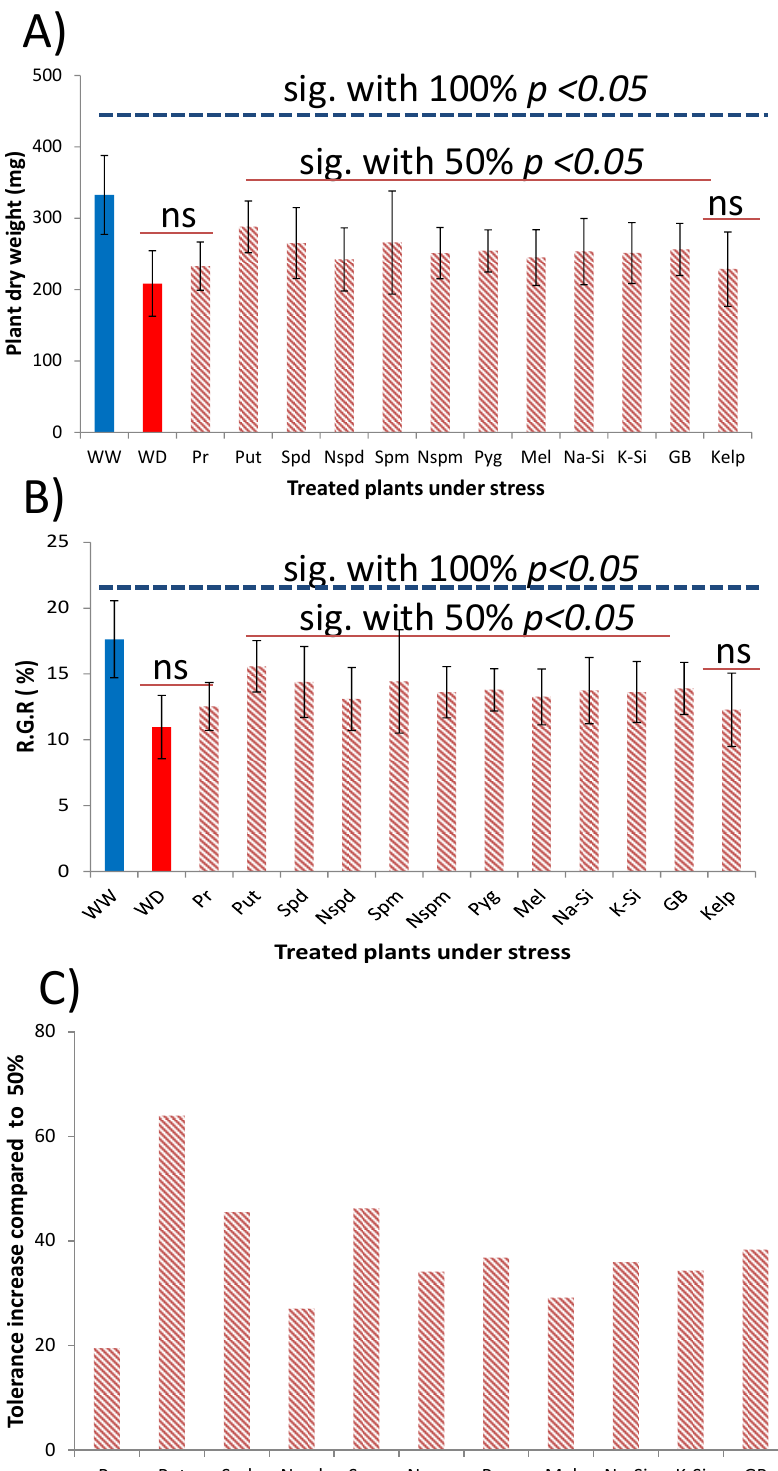
Figure 7. ( A ) Biostimulants DW (Dry Weight), ( B ) RGR (Relative Growth Rate) and ( C ) Growth differences (%) compared to water-deficit treated seedlings after seven days of the experiment. Kelpak ® was omitted from the third graph because it showed no differences with the water-deficit treated seedlings. ns, not significant.